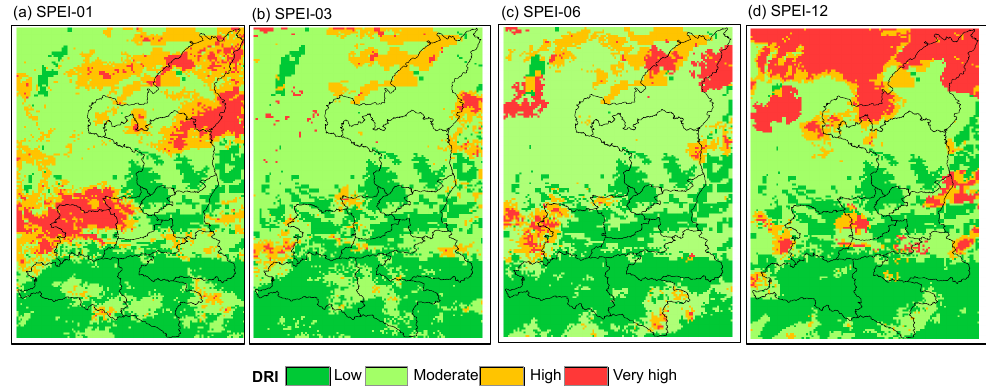
Figure 9. Spatial patterns in drought risk index (DRI) under four typical timescales of SPEI: the SPEI-01 ( a ), SPEI-03 ( b ), SPEI-06 ( c ), and SPEI-12 ( d ).